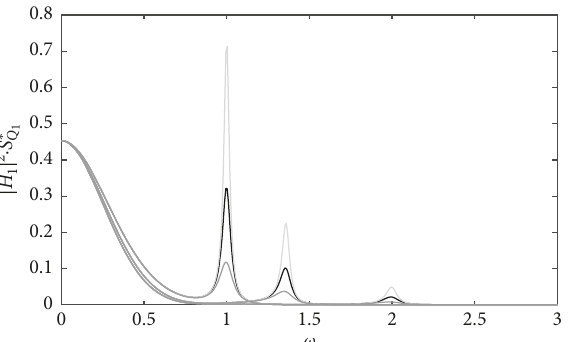
Figure 4: Scaled modal component of the deflection PSD | H ( ω 1 � 1, 1.36, and 2Hz) and 3 different values of damping ratio ( ζ 1 � 0.02, 0.03, and